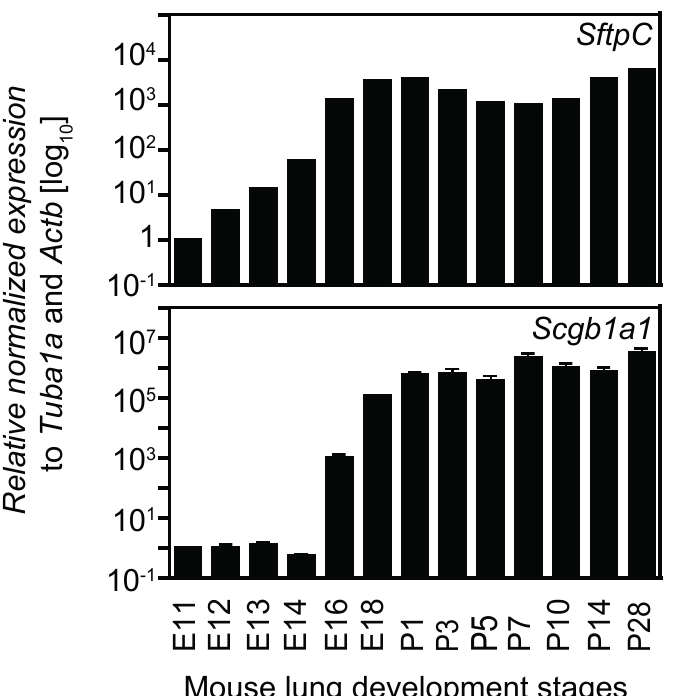
Figure 7. Expression analysis of two cell lineage markers during mouse lung development using a combination of two reference genes for normalization. Expression of surfactant protein C ( SftpC ) and Clara cell-specific 10 kDA protein ( Scgb1a1 ) was analysed during lung development by qRT-PCR. Expression analysis in all stages of lung development was normalized to both Tuba1a and Actb . Days post coitum , E ; postnatal, P . Data are represented as mean ± SD; n =